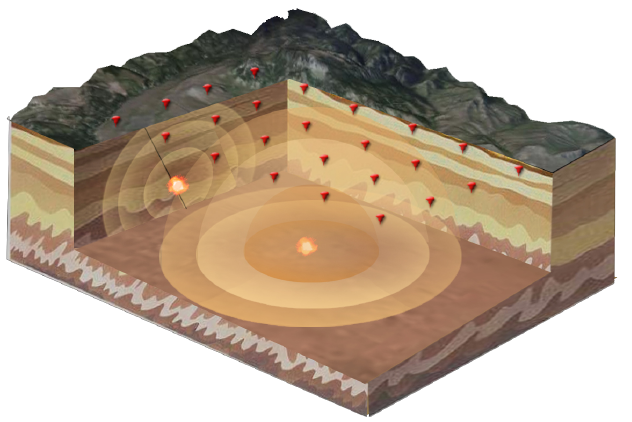
Figure 1. An illustration of the seismic sensor network for microseismic source event